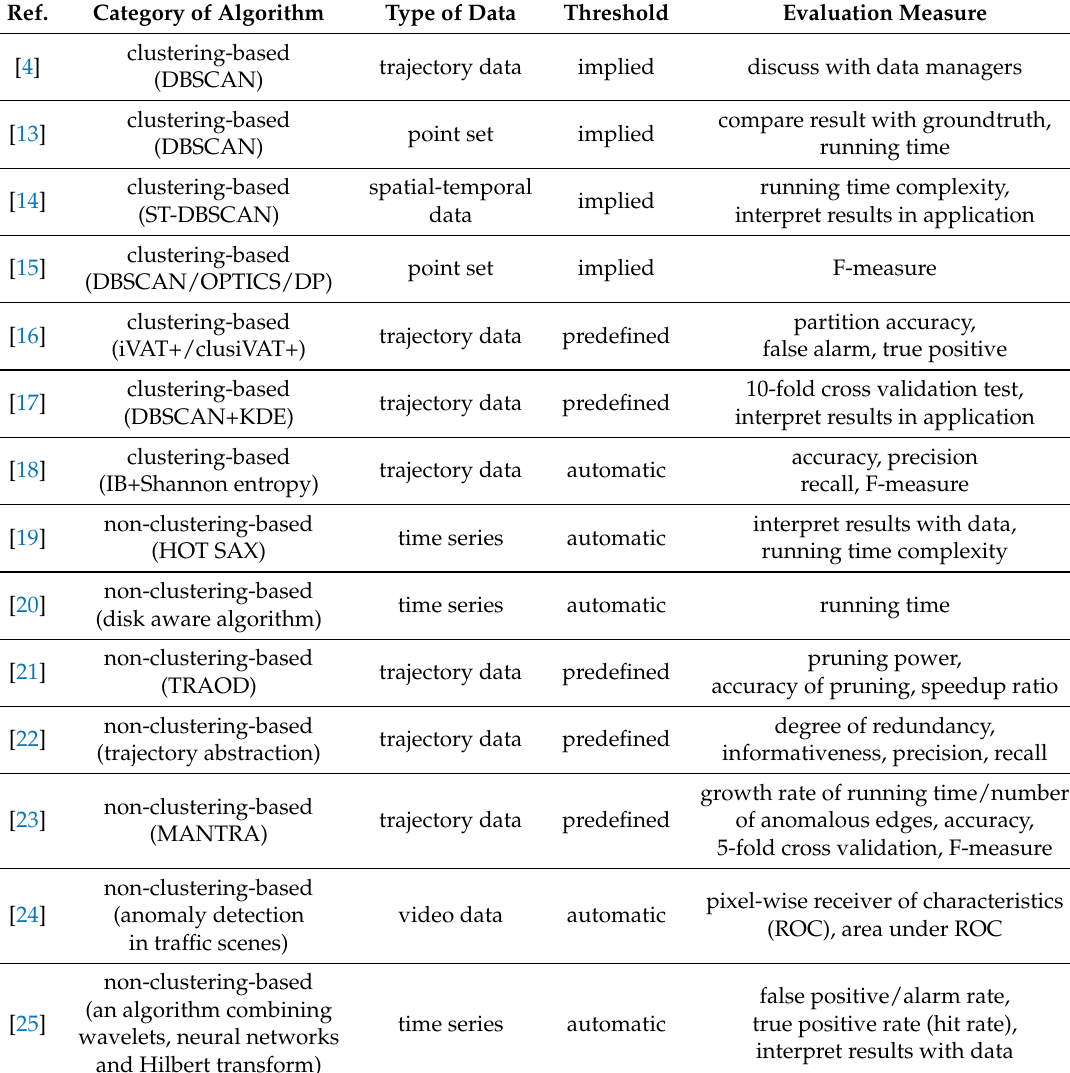
Table 1. Overview of anomaly detection in several related